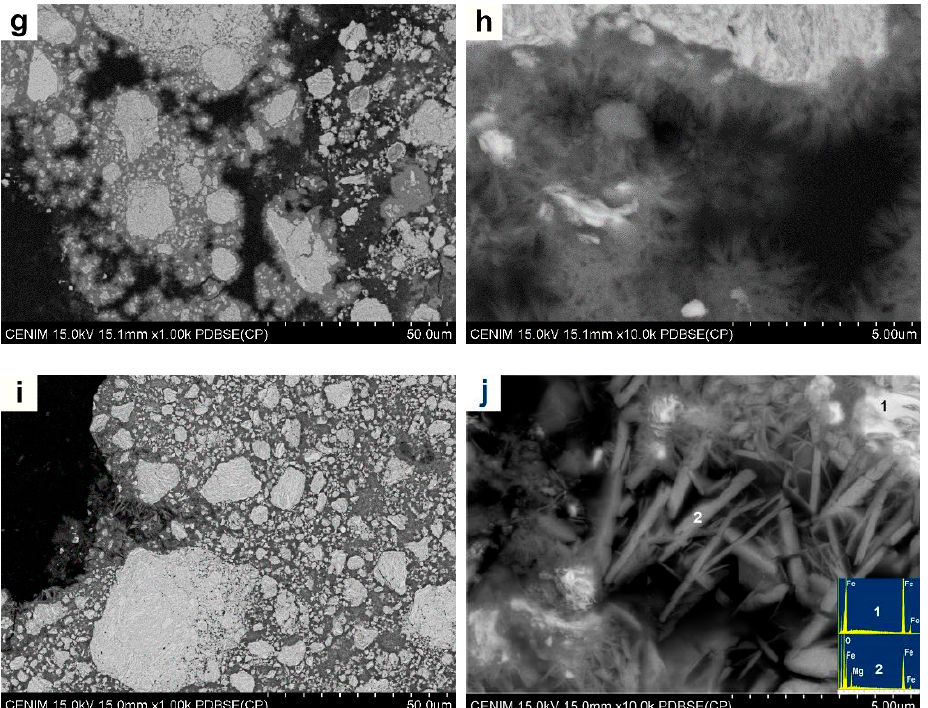
Figure 4. SEM micrographs of ( a , b ) as-received Fe powder degraded for 14 days; ( c , d ) SEM micrographs of Fe16h powder degraded for 3 days; ( e , f ) Fe16h powder degraded for 14 days; ( g , h ) Fe5Mg16h powder degraded for 3 days; and ( i , j ) Fe5Mg16h powder degraded for 14 days.